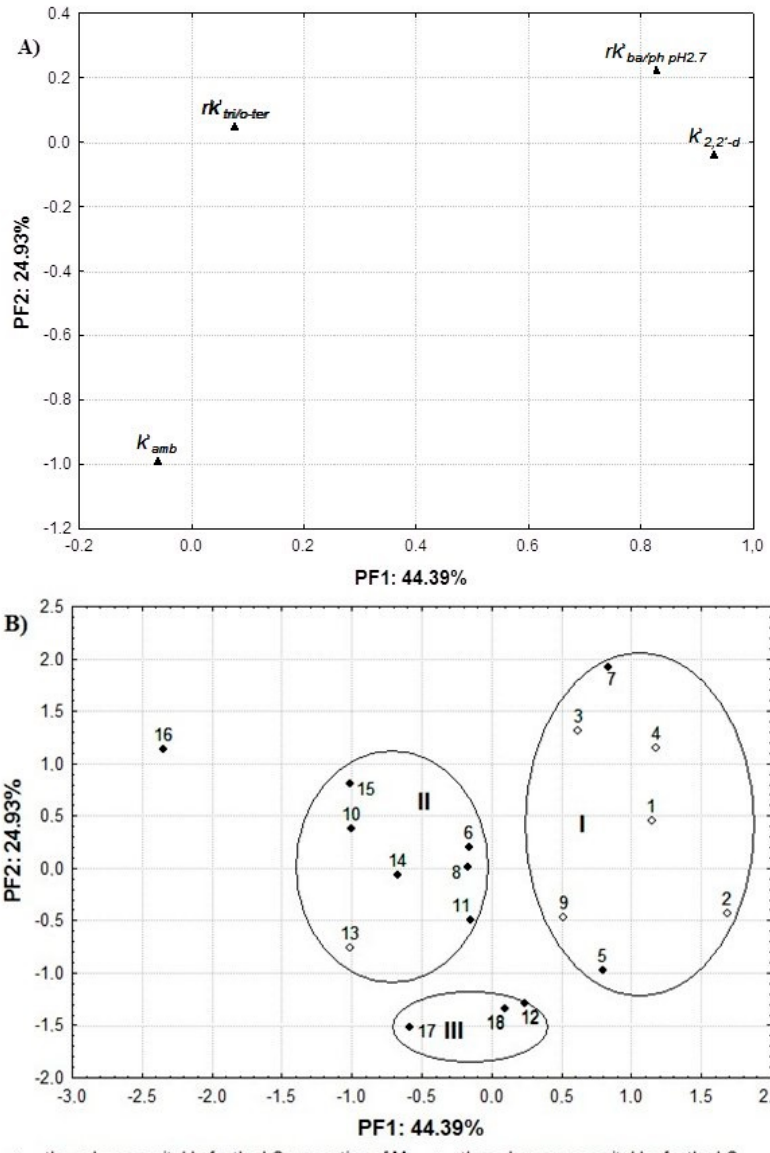
Figure 1. The FA plot of the variables ( A ) and objects ( B ) established based on the auto-scaled KUL test parameters calculated for the 18 columns studied.